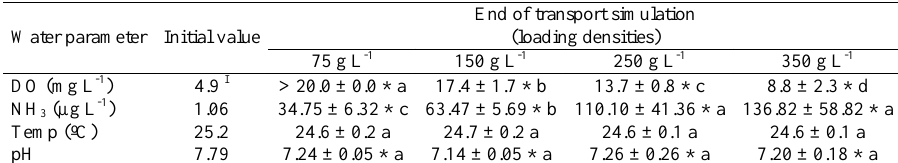
Table 1. Dissolved oxygen (DO), pH, un-ionized ammonia (NH ) and temperature (Temp) in water before and after transport 3 simulation with jundiá juveniles in plastic bags at different loading densities. Asterisks indicate significant differences (P < 0.001) when compared to the initial values before transport. Different lowercase letters in the rows indicate significant differences (P < 0.05) among treatments after transport period. I Average initial value before the addition of pure oxygen. When plastic bags were locked, dissolved oxygen was over 20.0 mg L -1 in all treatments.